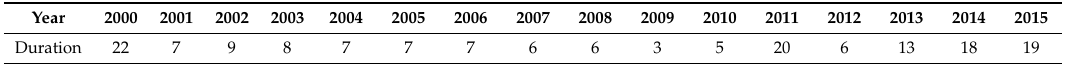
Table 4. The number of ice-induced events larger than 5 h. The year number indicates the start of the winter (2000—winter 2000/2001).